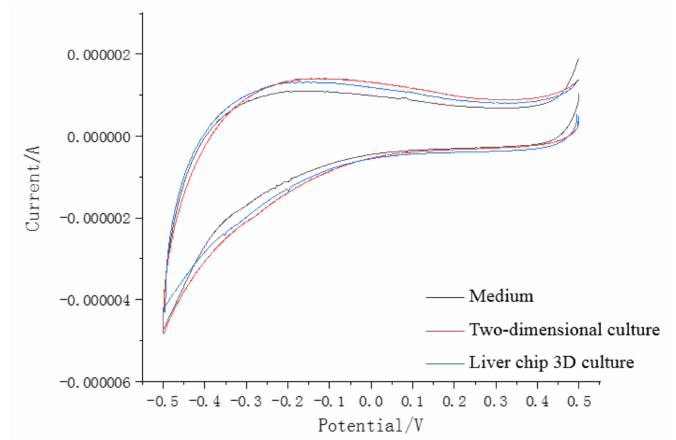
Figure 5. The electrochemical impedance of various liquid environment (day